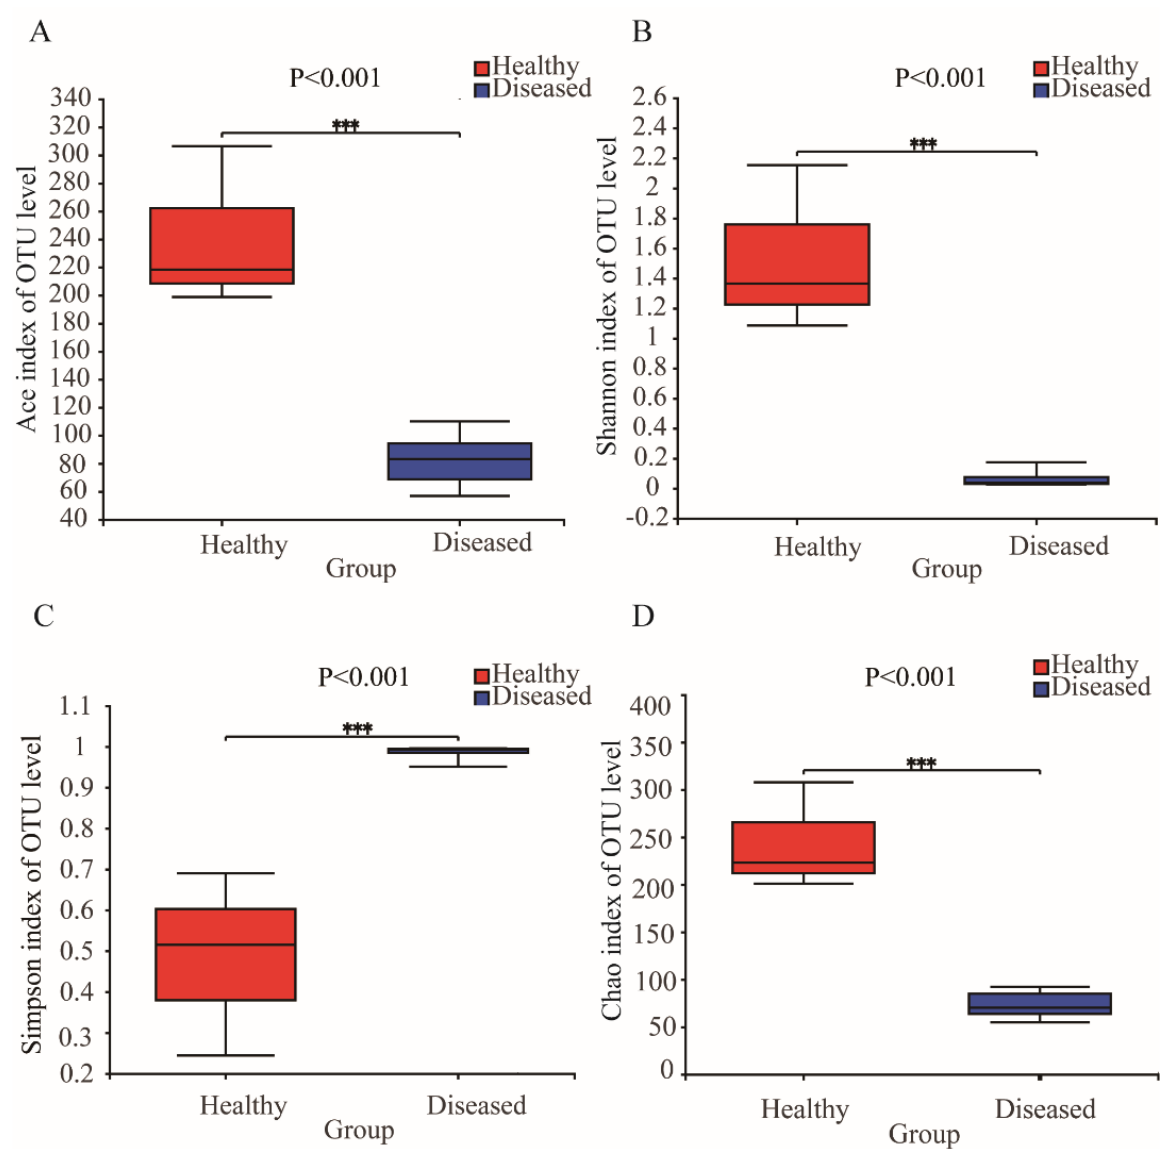
Figure 1. ( A ) Comparison of the Ace index of the bacterial communities in the healthy and diseased fish; ( B ) comparison of the Shannon index of the bacterial communities in the healthy and diseased fish; ( C )comparison of the Simpson index of the bacterial communities in the healthy and diseased fish; ( D )comparison of the Chao index of the bacterial communities in the healthy and diseased fish. Statistical significances between the two groups were considered at *** p < 0.001 by Student’s t test. Table 1. Analysis of similarity (ANOSIM) of the structure and function of the bacterial communities among three groups. R is assessed by permuting the grouping vector to obtain the empirical distribution of R under the null model; a p value less than 0.05 means significant. Community Structure Community Function Group R Whole comparison Healthy fish vs. Diseased fish 0.77 Healthy fish vs.